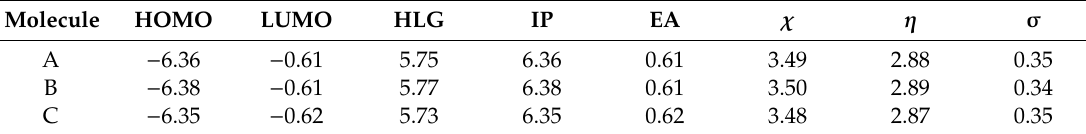
Table 6. Calculated energies of HOMO, LUMO, HOMO LUMO gap (HLG), Ionization Potential (IP), Electron A ffi nity (EA), Electronegativity ( χ ), Absolute Hardness ( η ) and Softness ( σ ) in eV at B3LYP / 6-311 + G (d, p)